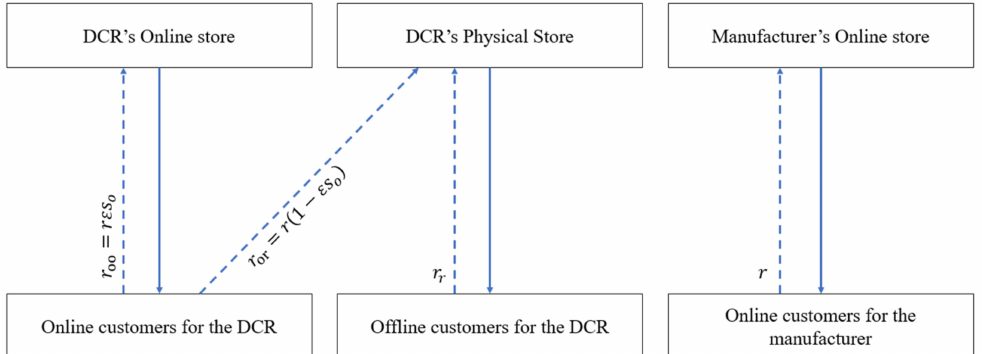
Figure 1. Forward and backward flow of products in a two-echelon retailing